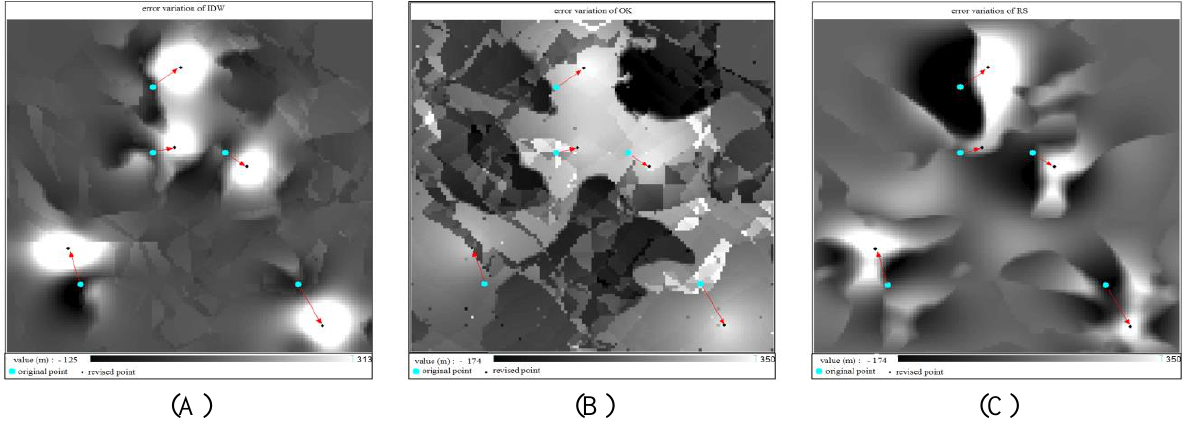
Figure 15. The variations of the errors at the sampling points of area A. ( A ) Error variations at the sampling points of IDW in area A; ( B ) Error variations at the sampling points of OK in area A; ( C ) Error variations at the sampling points of RS in area